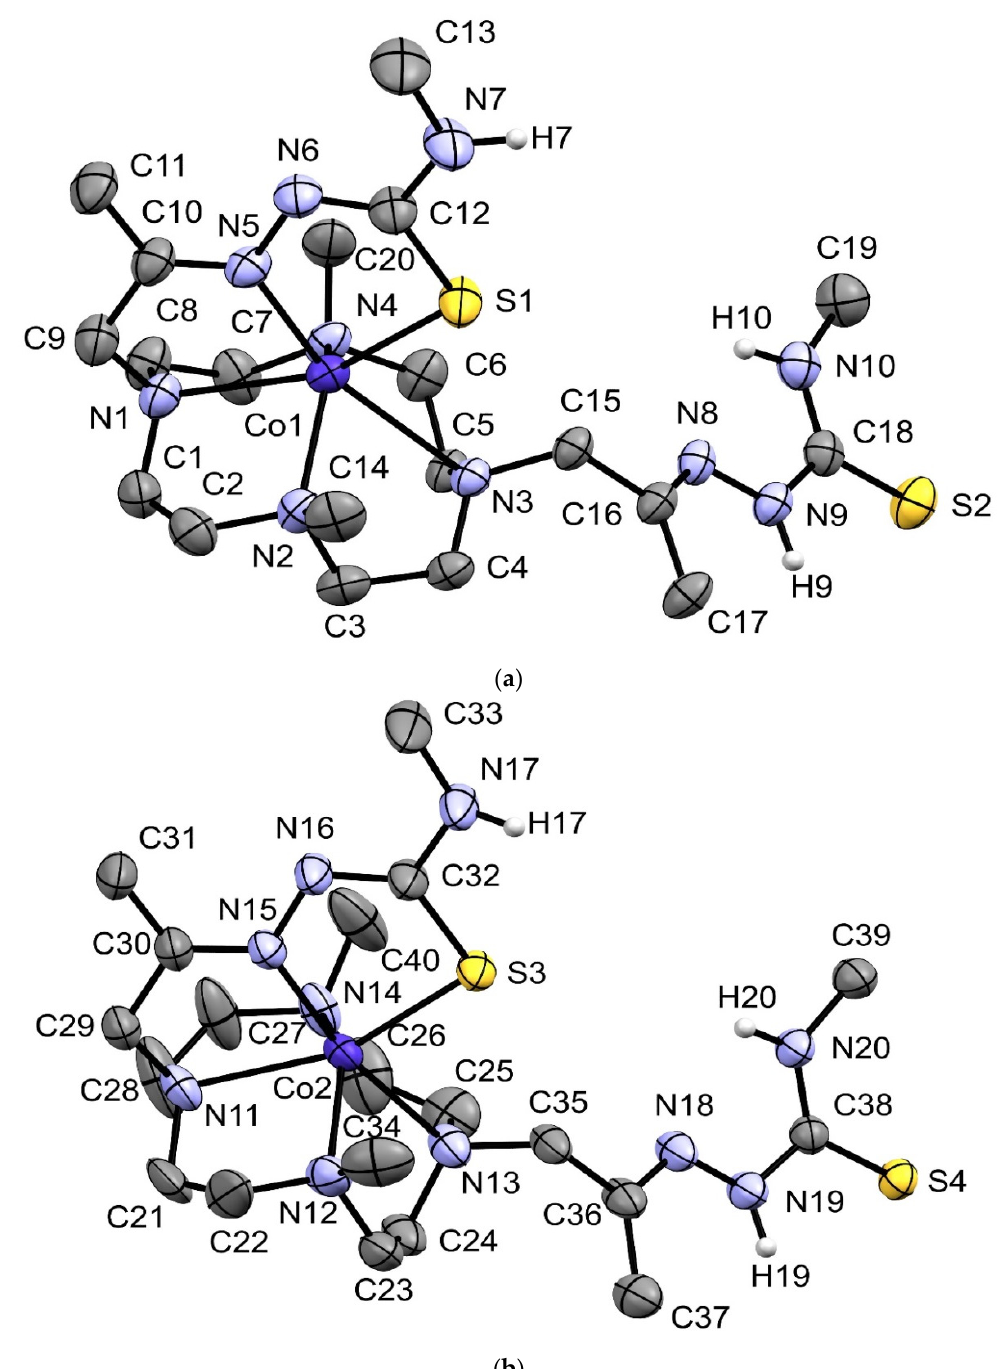
Figure 4. Single-crystal X-ray diffraction structure representations of the ( a ) [Co1H L ] + and ( b ) [Co2H L ] + complex cations at 30% thermal ellipsoid probability. Hydrogen atoms are omitted for clarity (except hydrogen atoms bound to nitro- gen).